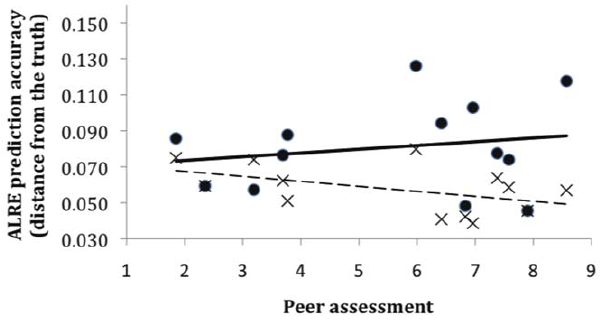
Figure 2. Peer assessment of expert knowledge versus actual performance for the participants in Workshop 3. Prediction accuracy is calculated as ALRE (see text). Small values for prediction accuracy are better. Closed circles and the solid line are estimates from round 1 ( r =0.19). Crosses and the dashed line are estimates from round 2 ( r = 2 0.47). Estimates closer to the x-axis indicate the answers are closer to the truth.